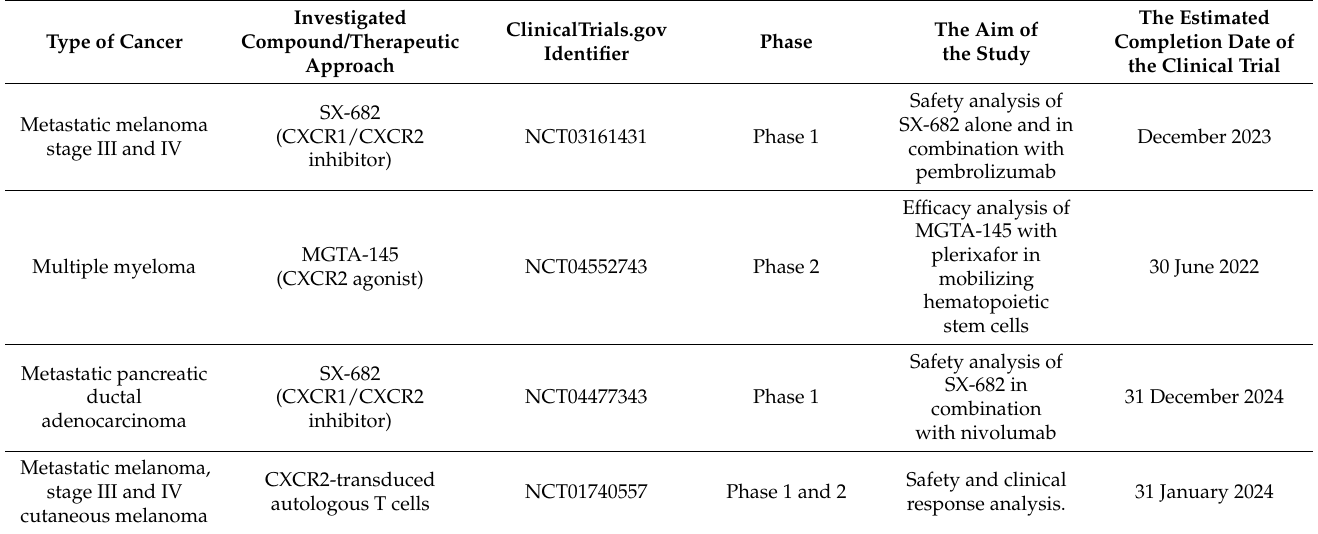
Clinical trials available on the ClinicalTrials.gov NIH U.S. National Library of Medicine